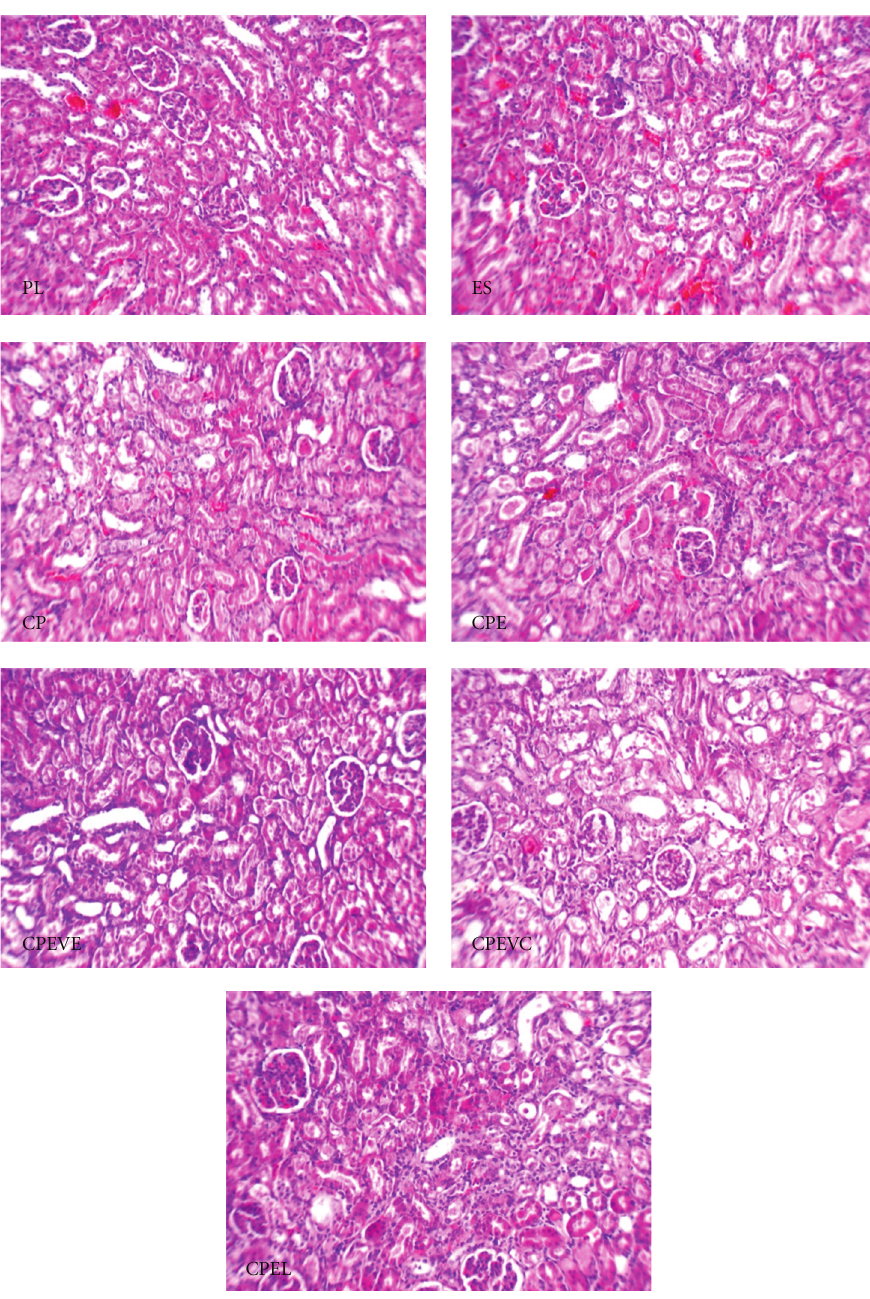
Figure 3: Images (magnification × 100) of kidney tissue. PL, ES, CP, CPE, CPEVE, CPEVC, and CPEL inside the images stand for groups treated with vehicle (placebo, group 7), estradiol valerate (group 6), CP alone (group 5), estradiol and CP (group 1), estradiol plus vitamin E and CP (group 2), estradiol plus vitamin C and CP (group 3), and estradiol plus losartan and CP (group 4), respectively. No tissue damages were seen in PL and ES, but higher and almost similar tissue damages were observed in other